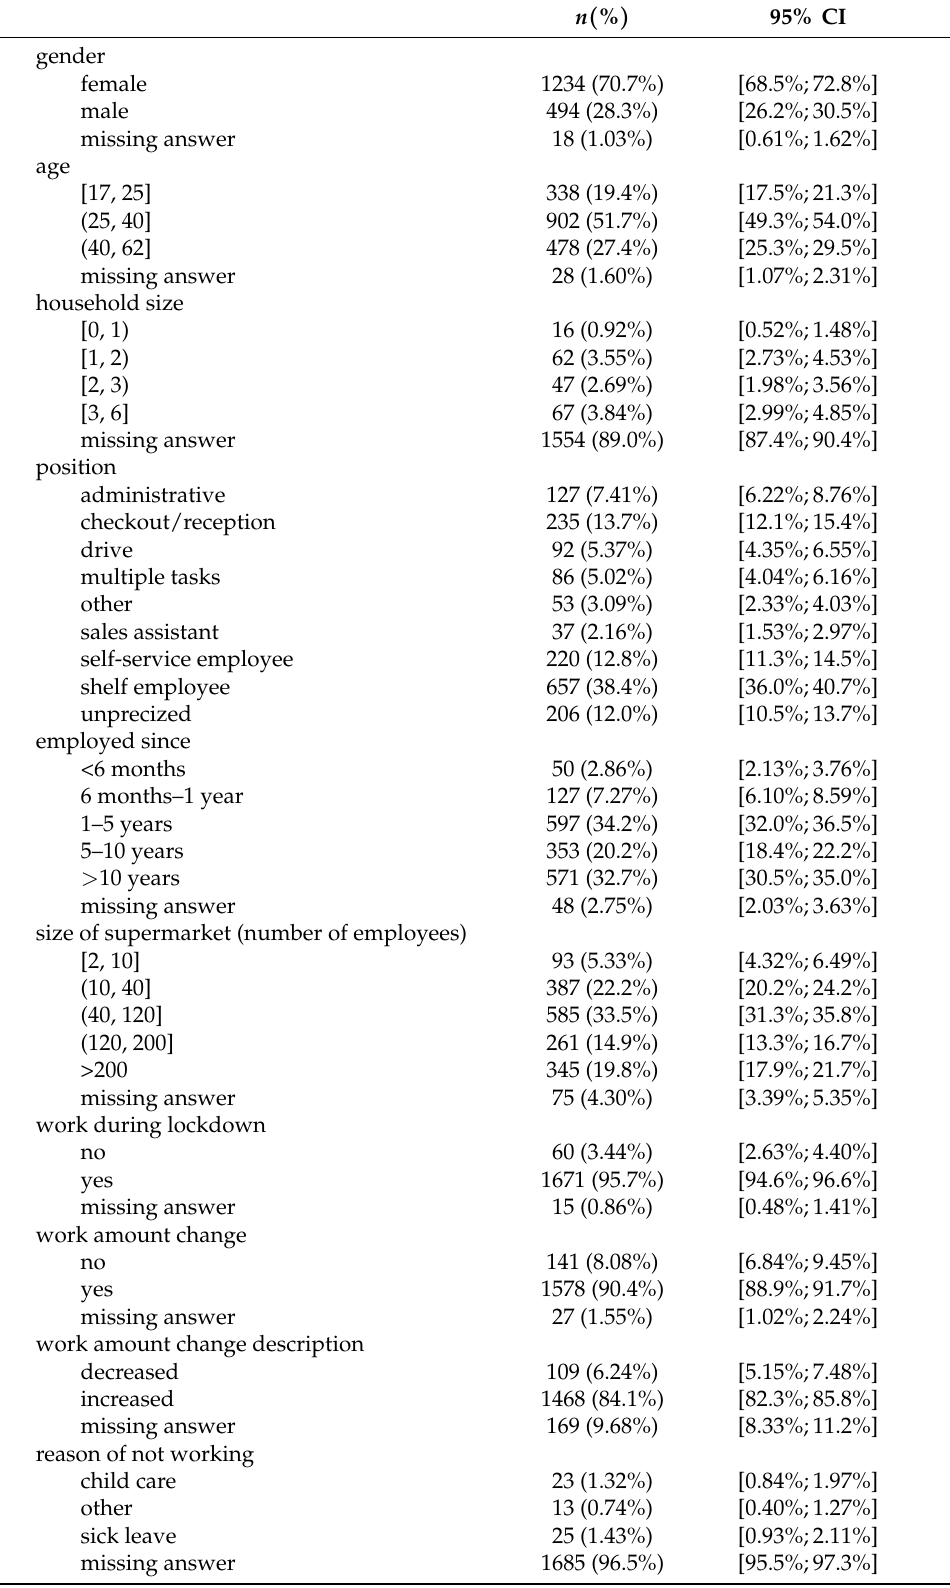
Table A1. Descriptive statistics for all employees ( n = 1746, a 95% confidence interval is